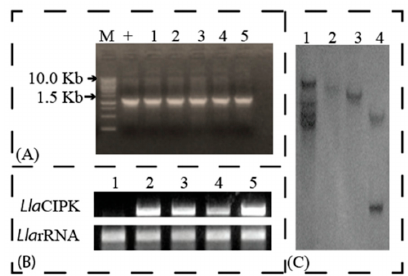
Figure 6. Molecular characterization of Lla CIPK overexpressing tobacco plants: ( A ) Electrophoretic analysis of Lla CIPK PCR product amplified from genomic DNA isolated from different lines of transformed tobacco plants. Lane M-DNA Marker, Lane + positive control, & Lanes 1 to 5 are PCR amplified fragments from 5 different transgenic lines. ( B ) Expression of Lla CIPK in 5 different transgenic lines ( C ) Autoradiogram of Southern blot of Lla CIPK.